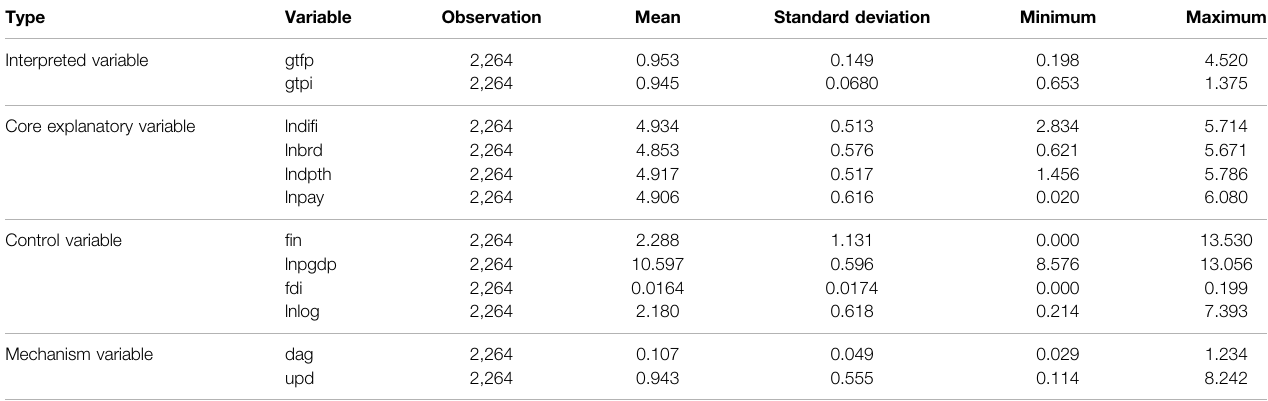
TABLE 1 | Descriptive statistics of variables.